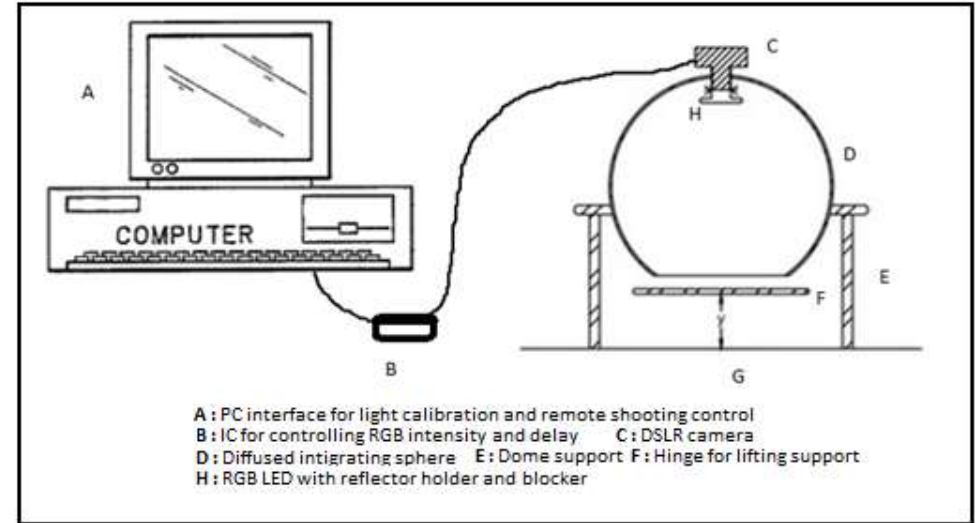
Figure 1. Integrated sphere imaging system with Illumination control.